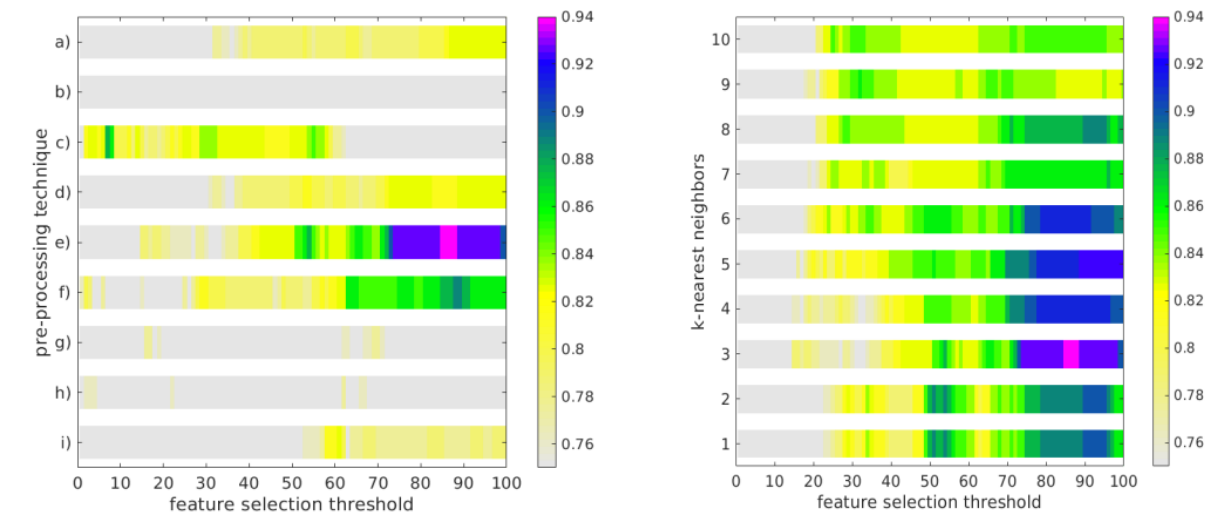
Figure 4. Accuracy of k-NN model 2 in nested-leave-one-cow-out cross-validation: with 3 neighbors, according to the preprocessing combinations described in Figure 2 (letters from a to i) and feature threshold ( left ), with different values of k-nearest neighbors, and feature selection thresholds ( right ).